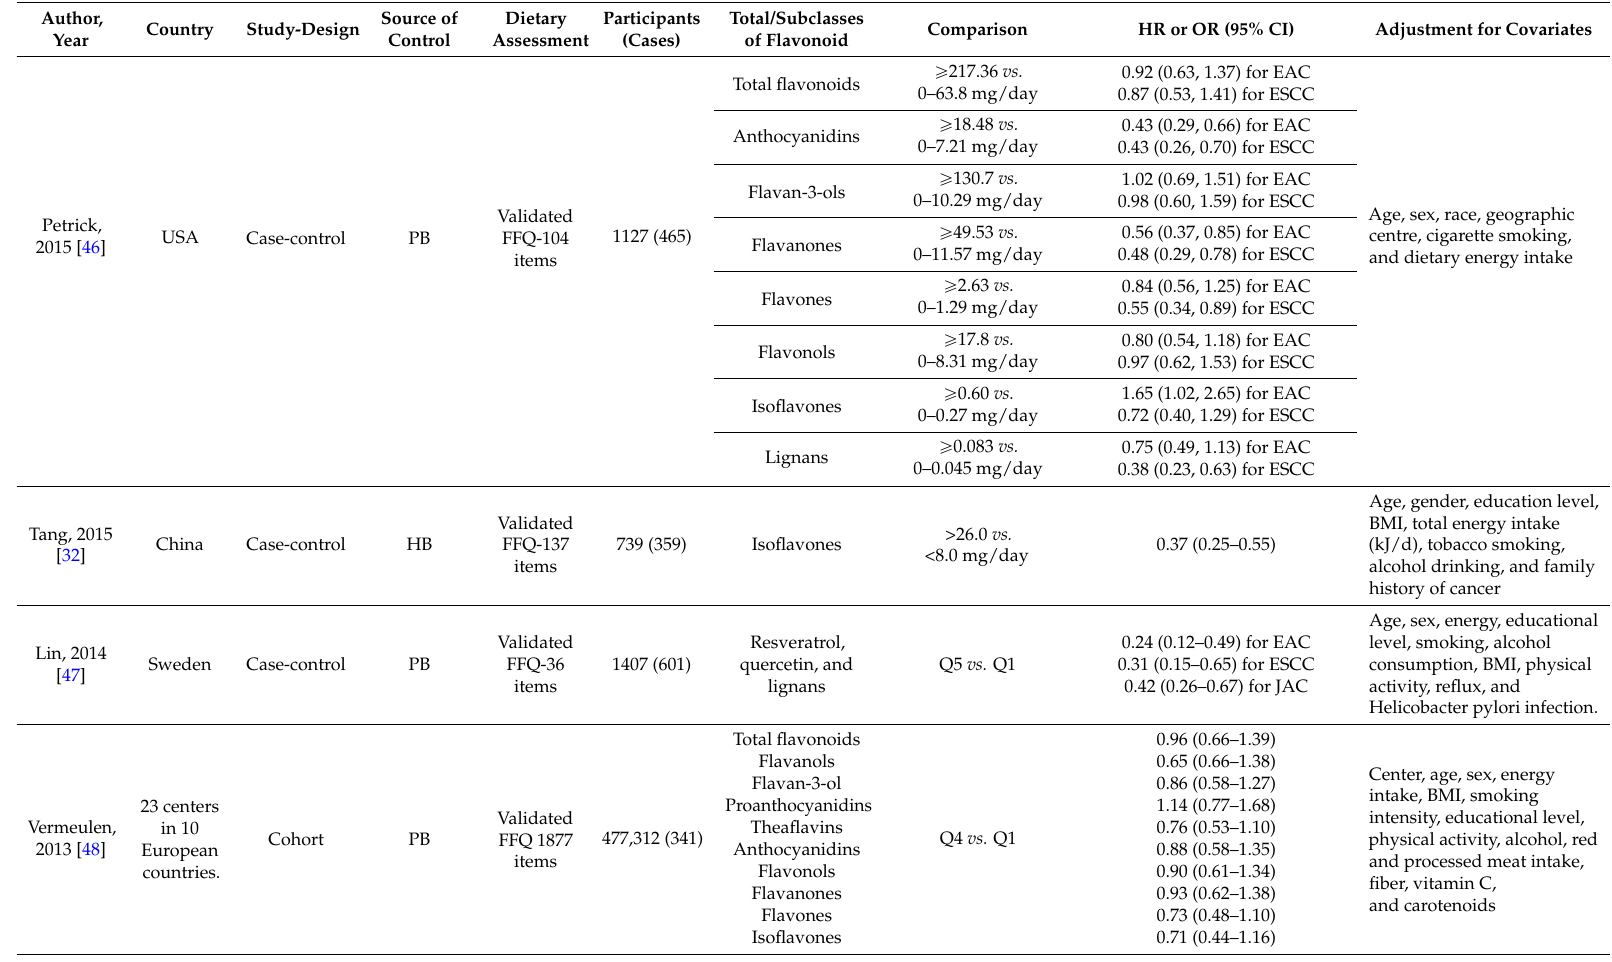
Table 1. Characteristics of the included studies of dietary flavonoid intake and risk of esophageal